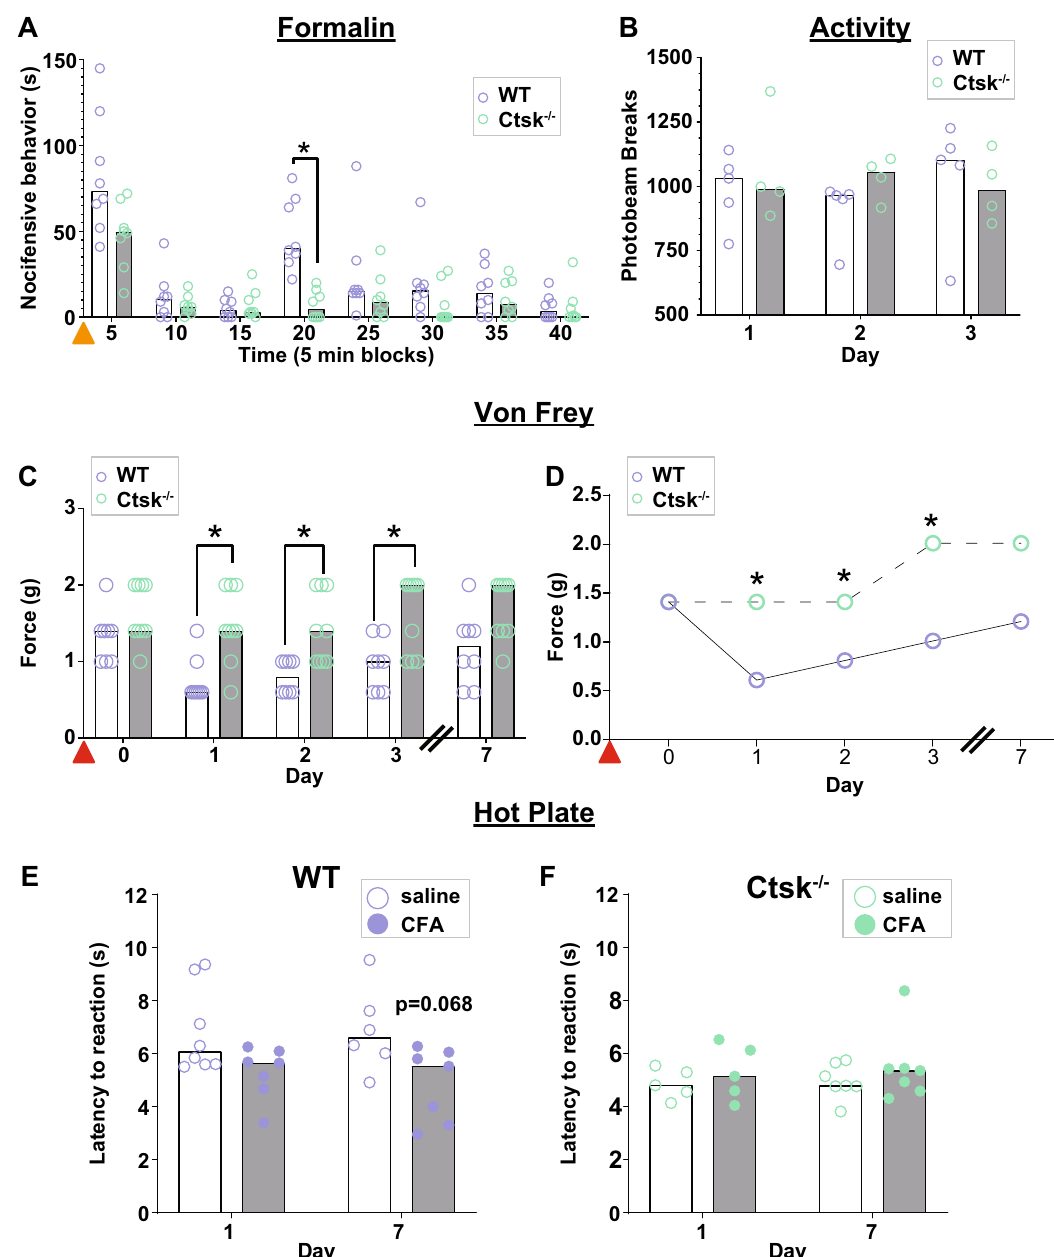
Figure 1. Cathepsin K knockout mice do not develop hypersensitivity to mechanical or thermal stimuli and have an attenuation in chemically induced nocifensive behaviors. ( A ) Formalin test, cathepsin K knockout ( Ctsk −/− ) mice have a reduction in nocifensive behaviors associated with the longer-lasting, more persistent phase of the formalin test compared to wild type (WT) mice. Orange triangle indicates the time of formalin injection. ( B ) General locomotor activity between WT and Ctsk −/− mice. ( C , D ) Compared to the WT mice, Ctsk −/− mice do not show mechanical hypersensitivity after complete Freund’s adjuvant (CFA) injection, shown as scatter plot overlayed with a bar graph representing the median; ( D ) line graph of the same data. Red triangle indicates the time of CFA injection. ( E ) CFA-injected WT mice show a trend towards thermal hypersensitivity after CFA injection, which is not seen in the CFA-injected Ctsk −/− mice ( F ). Data are represented at scatter plots of individual mice with bar graphs overlayed indicating the median value. *p < 0.05 multiple Mann–Whitney test between WT and Ctsk −/− mice for each time